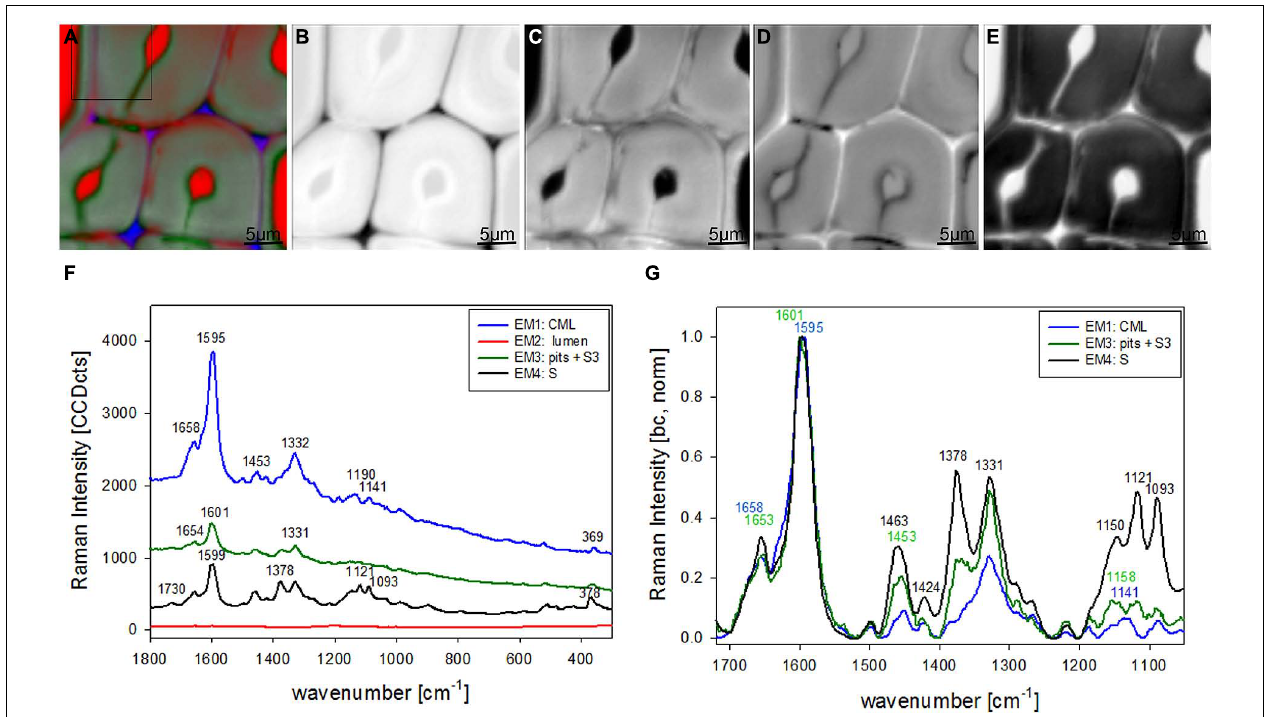
3 with high intensity in pit membrane and layer toward the lumen (S3; D), and EM 4 representing the secondary cell wall (E). The corresponding EM spectra are shown with original background and intensity (F) and after baseline correction and normalization on the aromatic stretching vibration at 1599 cm − 1 (G)